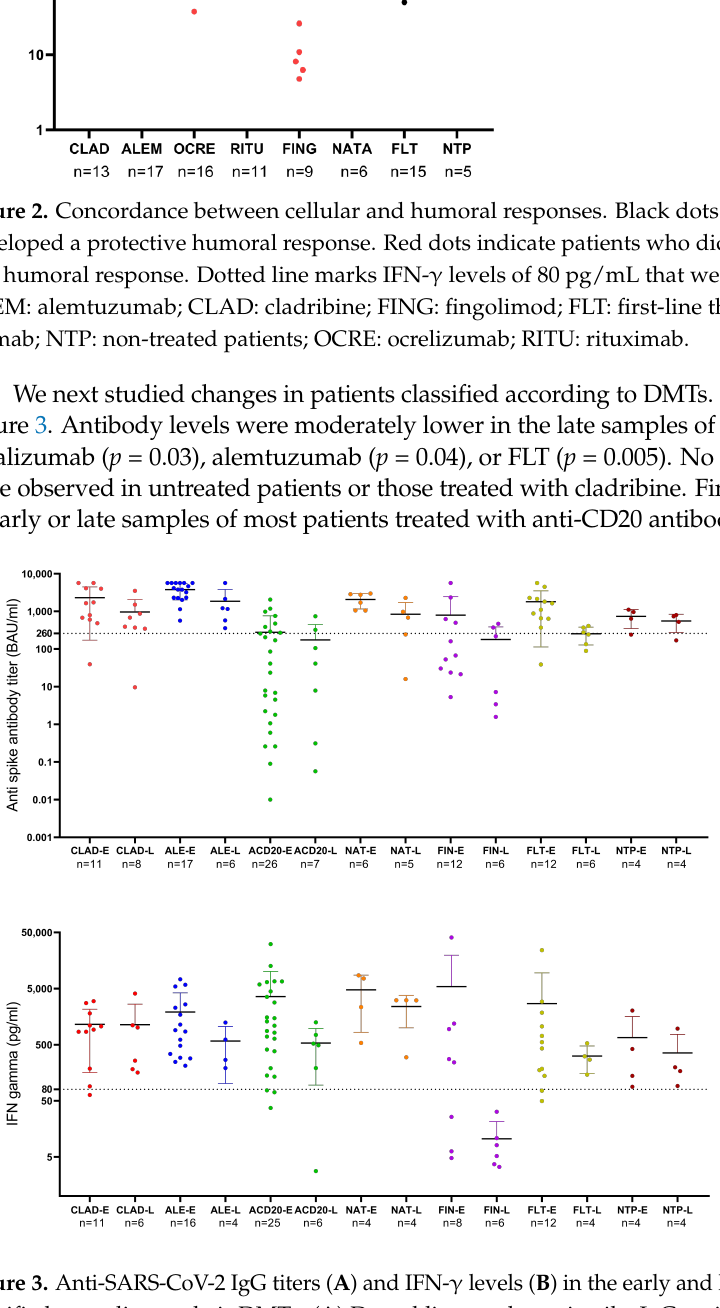
Figure 3. Anti-SARS-CoV-2 IgG titers ( A ) and IFN- γ levels ( B ) in the early and late samples of patients classified according to their DMTs. ( A ) Dotted line marks anti-spike IgG antibody titers considered protective (260 BAU/mL). ( B ) Dotted line marks IFN- γ levels of 80 pg/mL that were considered positive. ACD20: anti-CD20 therapies; ALE: alemtuzumab CLAD: cladribine; E: early sample; FIN: fingolimod; FLT: first-line therapies; L: late sample; NAT: natalizumab; NTP: non-treated